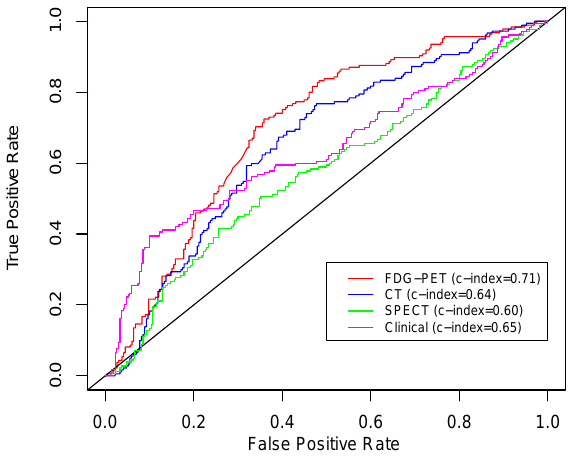
Figure 3. Receiver operating characteristic (ROC) curves and c-index values for different modalities. Table 2. Prediction performance of overall survival for the proposed model of FLSGL combined with CWGBS using a single time point or multiple time points for each modality. Values represent c-index (95% confidence interval) with p -values of the Friedman ANOVA test for multitask versus single task learning, as well as p -values of the Wilcoxon signed rank test for multitask learning of each modality relative to the benchmark model using clinical